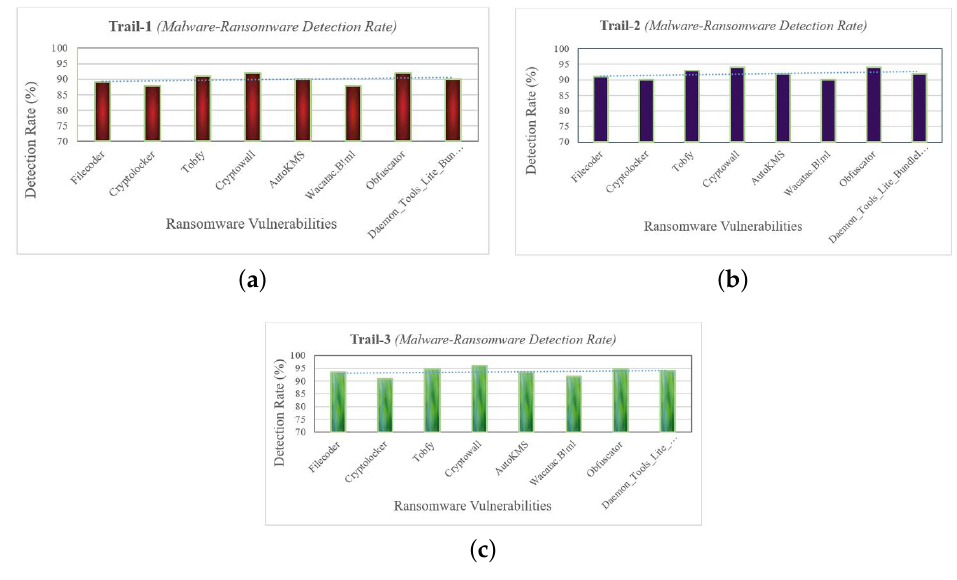
Figure 3. Ransomware detection rate ( a ) Trial 1, ( b ) Trial 2, ( c ) Trial 3. Figure 4 (i.e., extension of Figure 2) focuses on the feature extraction that is required to identify and optimize vulnerability detection process. The following characteristics were